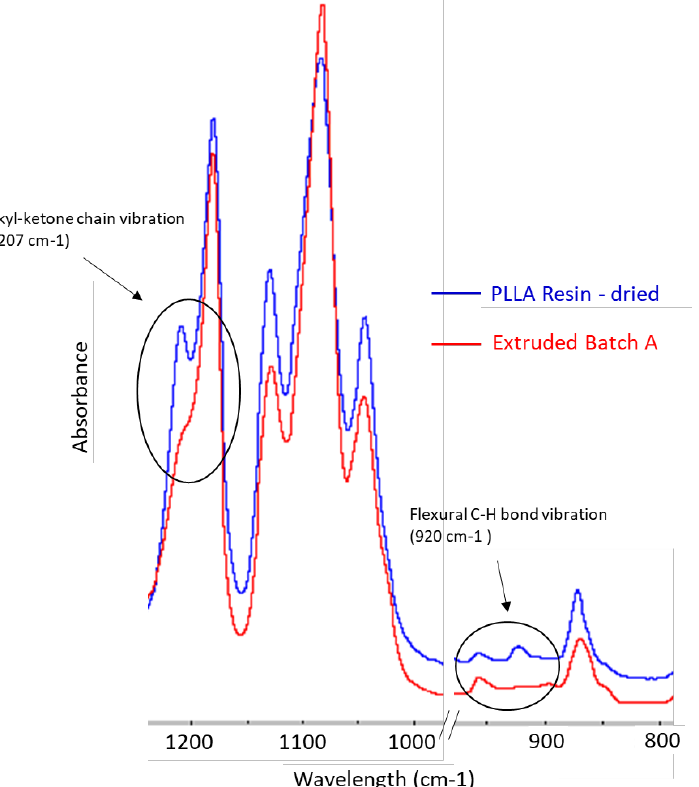
Figure 7. FTIR Spectra of dried resin (blue) and Batch A extruded tubing (red) in the wavelength range of 1250–800 cm −1 .